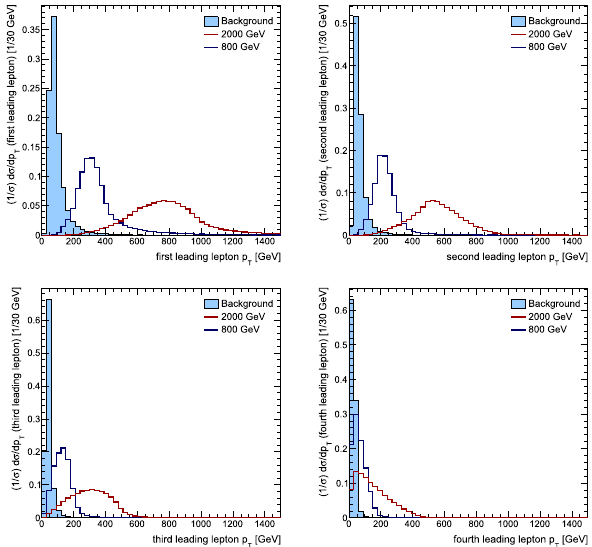
Fig. 10 Normalized differential cross sections as a function of leading lepton p T ( a ), second-leading lepton p T ( b ), third-leading lepton p T ( c ) and fourth-leading lepton p T ( d ) for m h 800 GeV (blue line) and background (blue solid) at